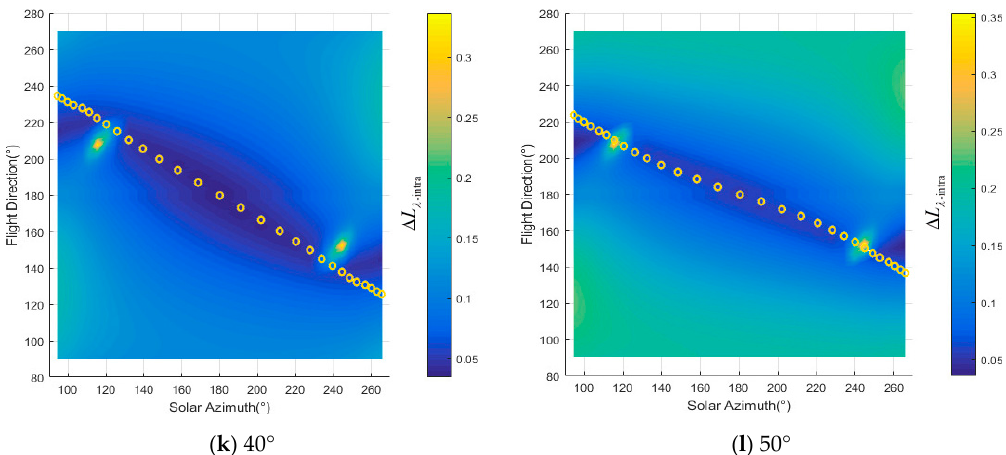
Figure 5. Radiance gradient for different illumination directions and flight directions: ( a )–( f ) the radiance gradient when aspect is 0° and slopes are 0° to 50° respectively, ( g )–( l ) the radiance gradient when aspect is 180°and slopes are 0° to 50° respectively.